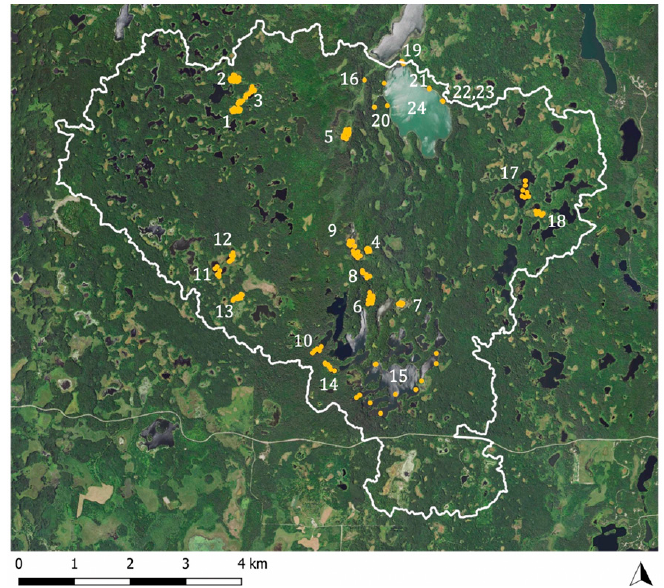
Figure 5. Wetland, pond, spring, and stream field measurement locations discussed in the text. Features referred to in the text: 1, Unnamed NW Pond 1; 2, Unnamed NW Pond 2; 3, Unnamed NW Pond 3; 4, Bog near Whipple Lake; 5, Nicolet Lake; 6, Triplet Lakes; 7, Unnamed Pond near Little Elk Lake; 8, Unnamed Pond near Whipple Lake; 9, Whipple Lake; 10, Augusta Lake; 11, Un-